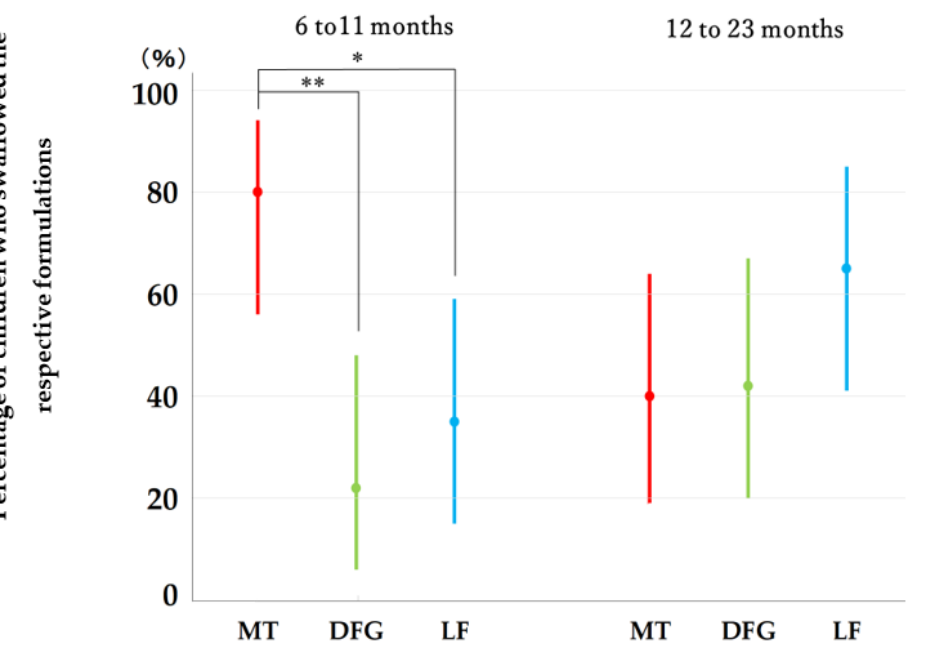
Figure 2. Percentage of swallowed minitablets (MT), fine granules (FG), and liquid formulations (LF). Each bar represents the 95% CI. McNemar’s test, * p < 0.05, ** p < 0.01.